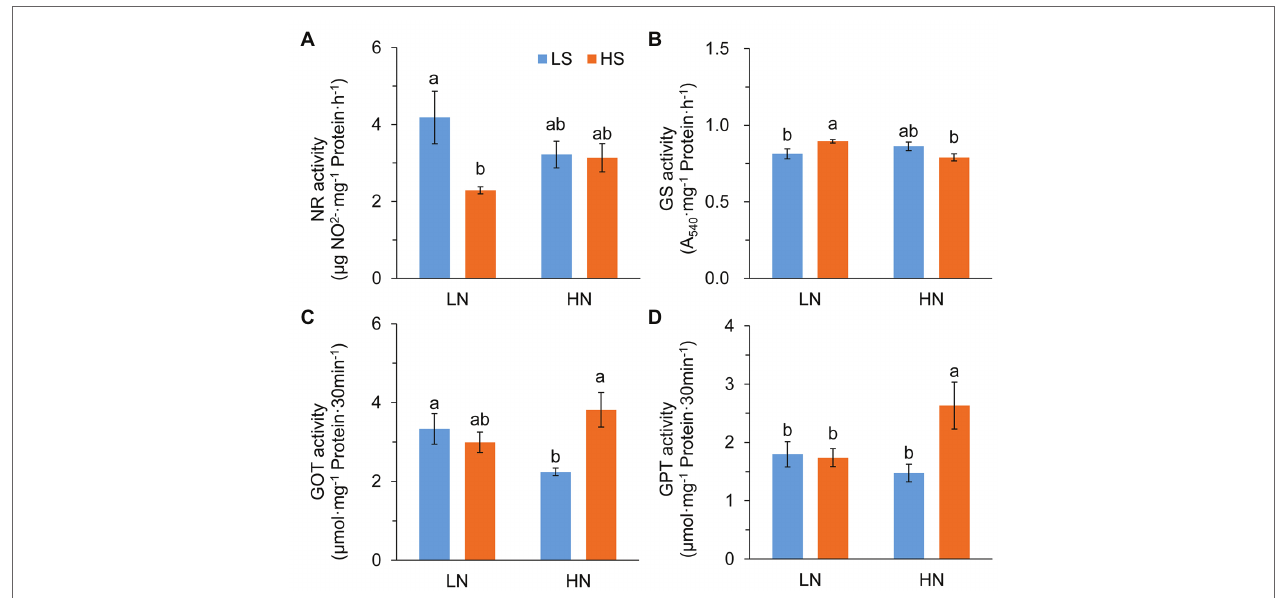
FIGURE 3 | Activity of N metabolic enzymes in leaves of A. paniculata plants grown under different nitrogen and sulfur conditions. (A) Nitrate reductase. (B) Glutamine synthase. (C) Glutamic-oxalacetic transaminase. (D) Glutamic-pyruvic transaminase. Data were presented as mean ± SE ( n = 4). Different letters on the bars indicate significant difference among treatments at p < 0.05 using the method of LSD . LN, low nitrogen; HN, high nitrogen; LS, low sulfur; HS, high